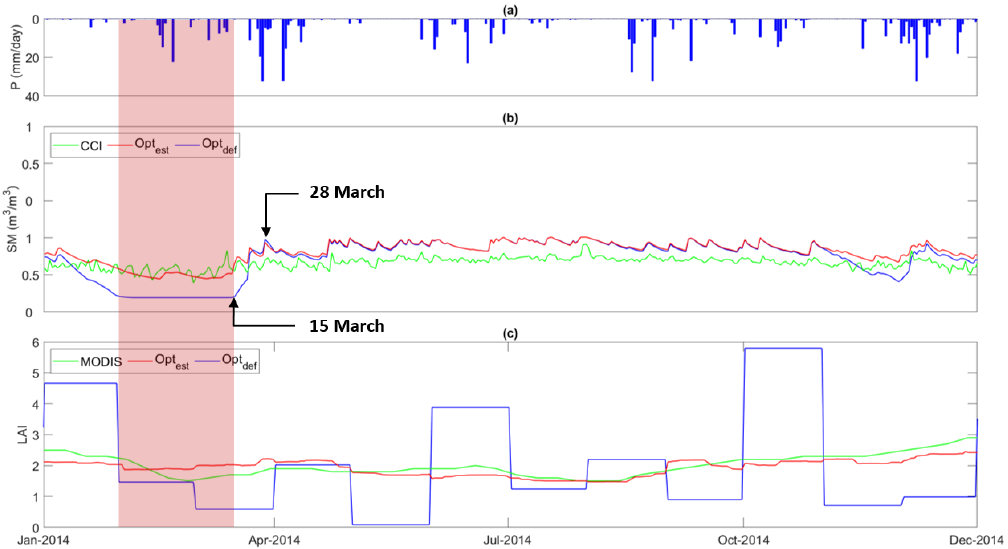
Figure 8. 1-year (2014) time series of ( a ) precipitation, ( b ) SM and ( c ) LAI for 318076 catchment.